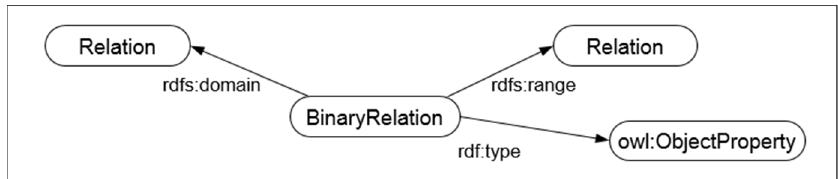
Figure 12. Semantic vocabulary of a binary relation (Rule 3).